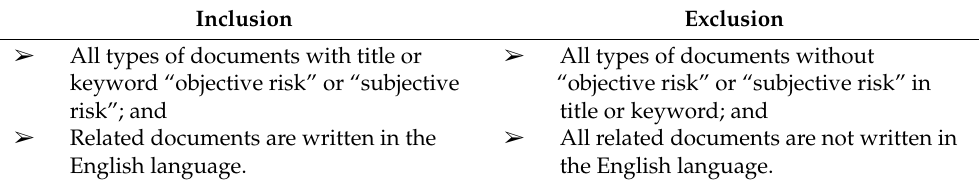
Table 1. Inclusion/exclusion